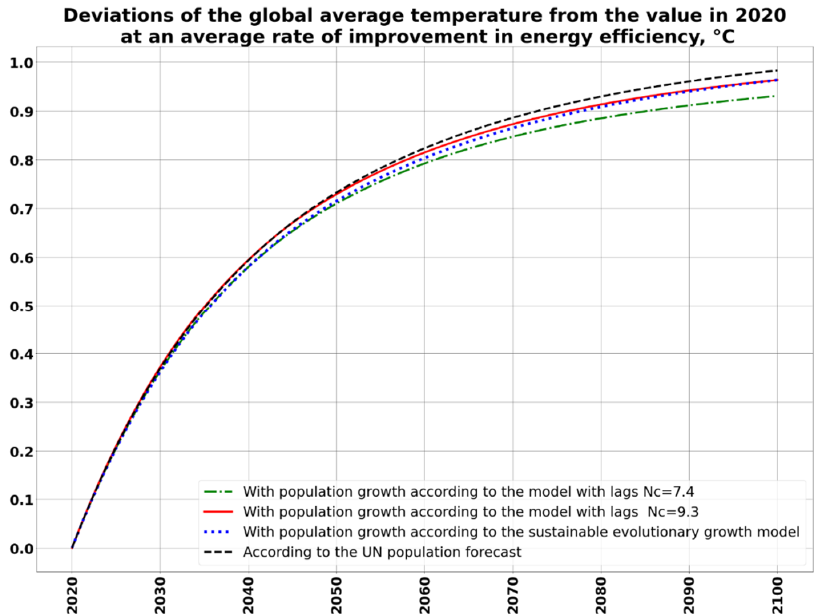
Figure 24. Dynamics of the deviation of the average global temperature of the surface atmosphere in the 21st century under the implementation of the conservative scenario of the energy transition, as well as the application of CCS technology in coal power engineering.